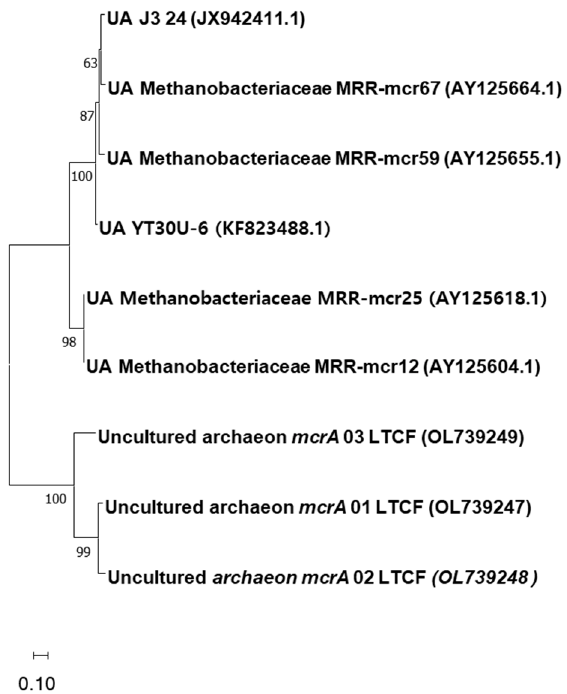
Figure 2. Phylogenetic tree showing the relationship between the partial mcrA DNA sequences of methanogens determined in this study with their closest identified sequences retrieved from GenBank. Bootstrap values are shown at the branch points. The tree is drawn to scale, with the branch lengths in the same unit as those of the evolutionary distances used to infer the phylogenetic tree.